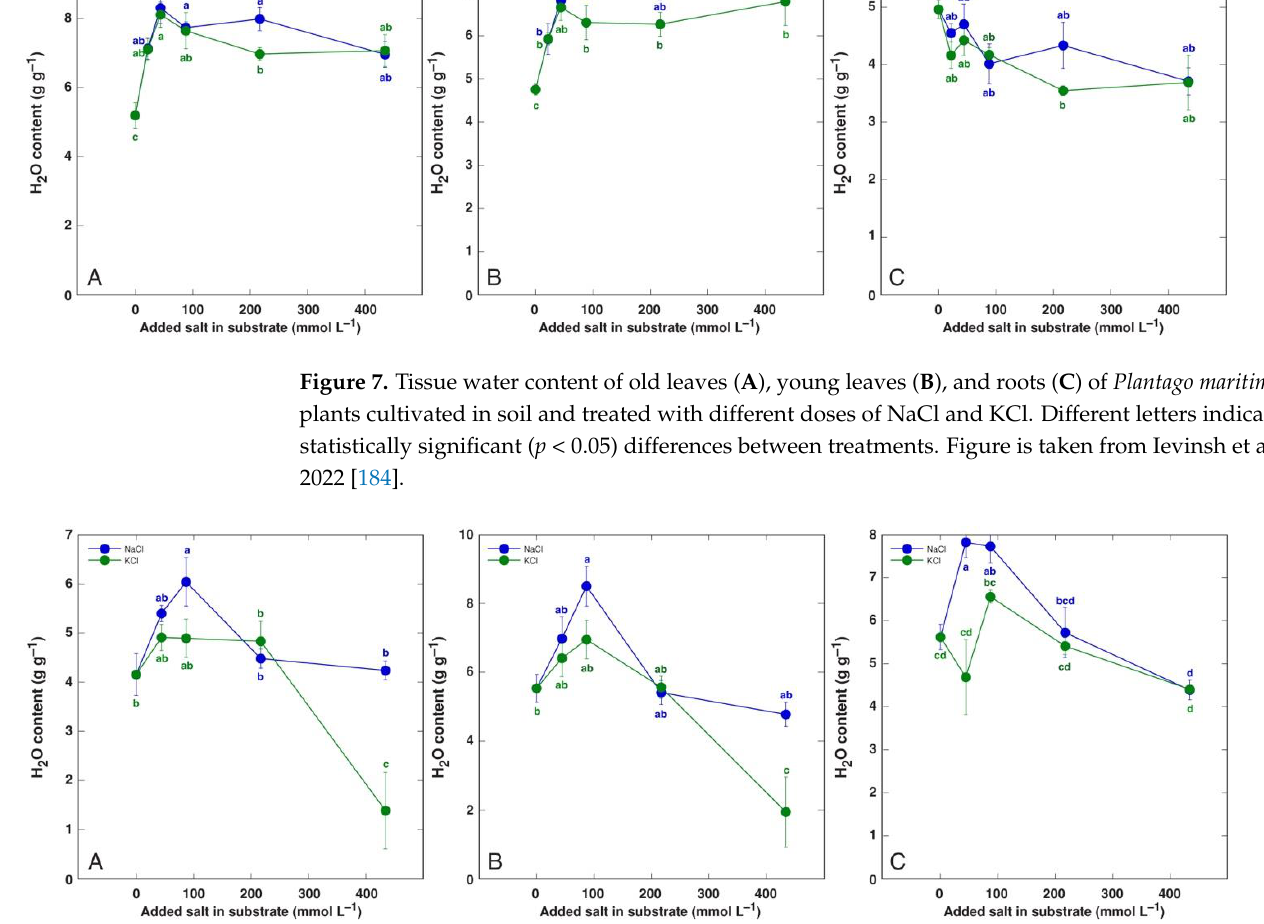
Figure 8. Tissue water content of old leaves ( A ), young leaves ( B ), and roots ( C ) of Cochlearia officinalis plants cultivated in soil and treated with different doses of NaCl and KCl. Different letters indicate statistically significant ( p < 0.05) differences between treatments. Figure is taken from Ievinsh et al., 2022 [184].